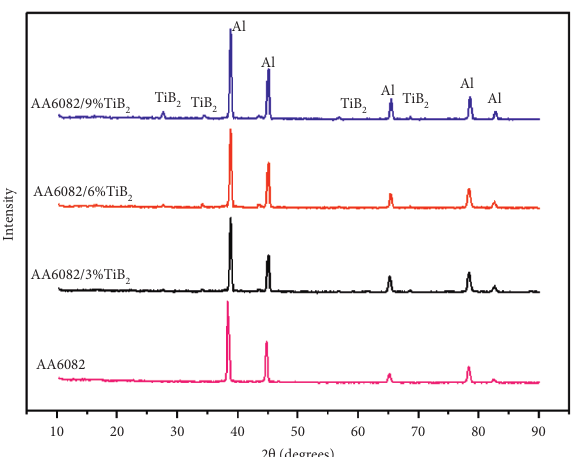
Figure 4: XRD patterns of the produced AA6082/TiB